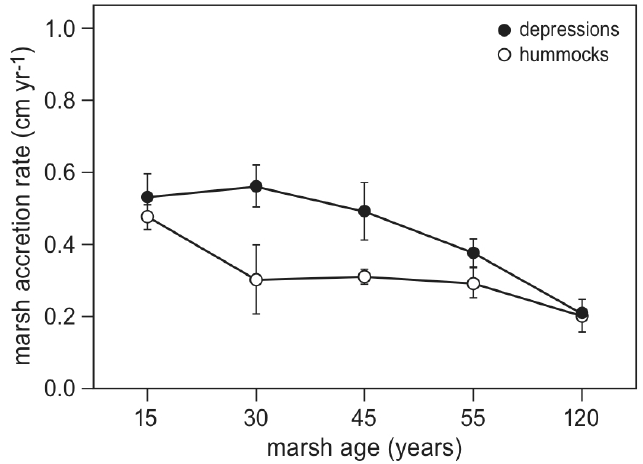
Figure 4. Marsh accretion rates (cm ∙ year − 1 ) based on annual measurements between 2001 and 2011 on hummocks and depressions along the natural chronosequence of Schiermonnikoog.